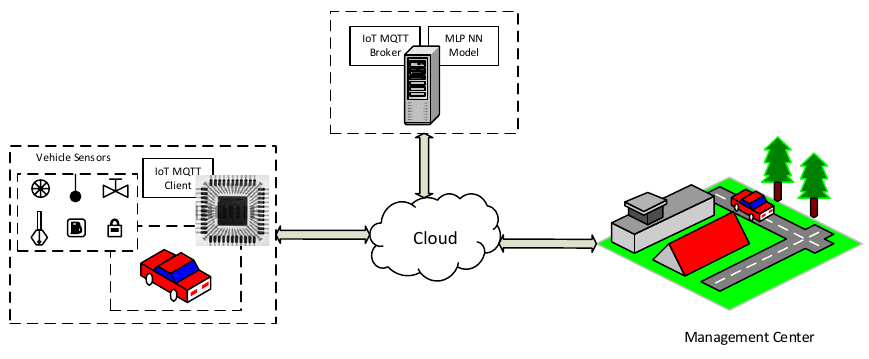
Figure 2. The proposed cloud-based architecture.